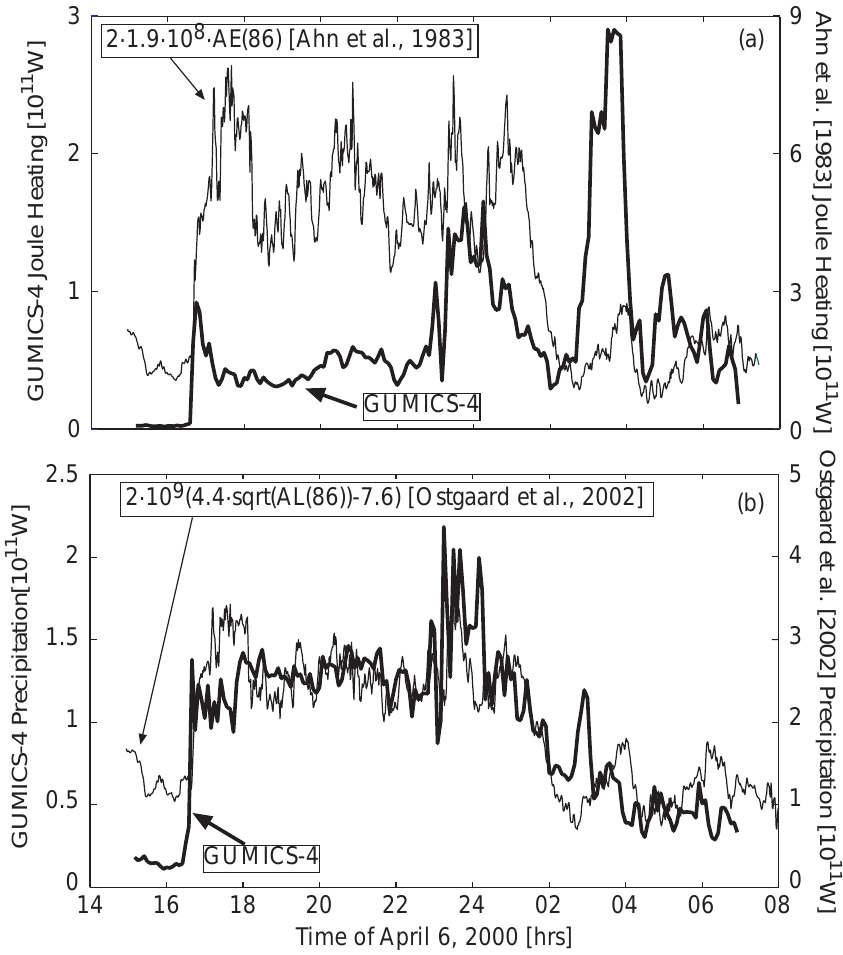
Fig. 3. (a) Joule heating power and (b) precipitation power in the ionosphere during the April 2000 storm as described by the GUMICS-4 global MHD simulation (thick line). The thin lines are calculated using equations presented in Ahn et al. (1983) and Østgaard et al.